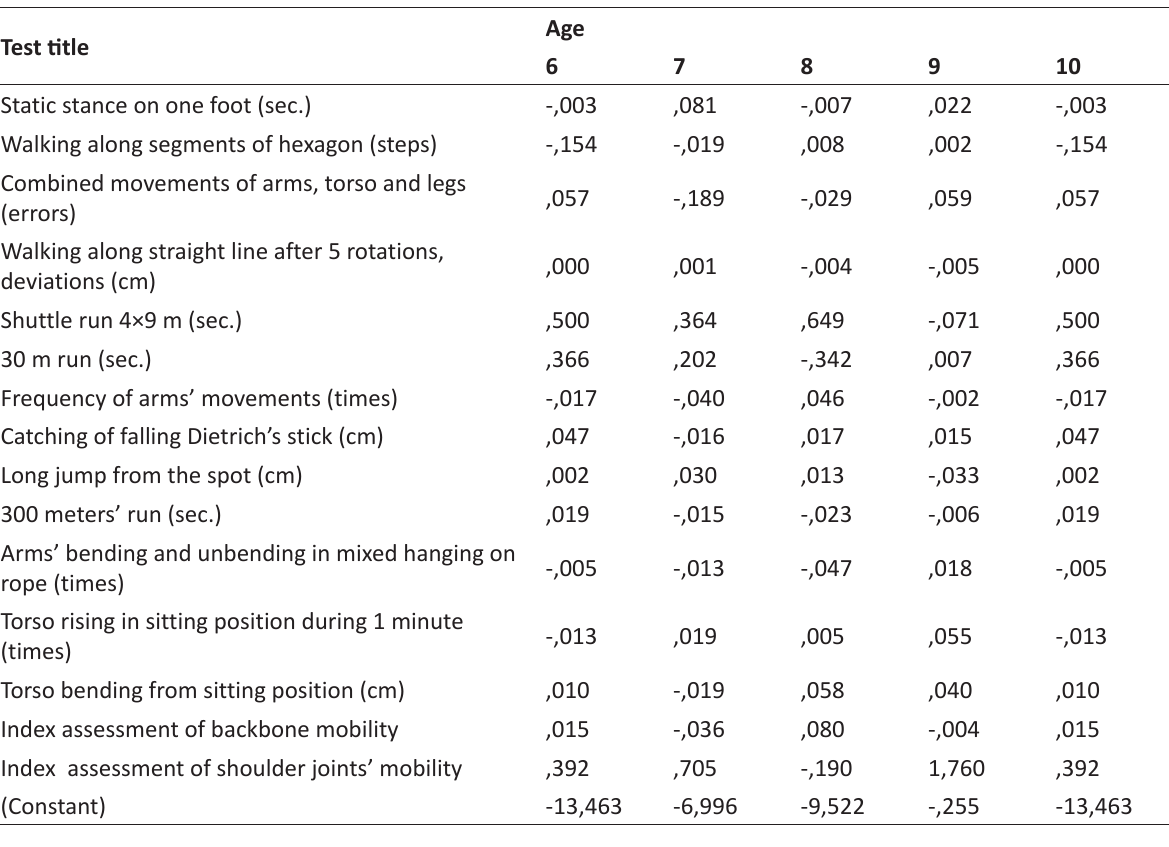
Table 2. Functions in groups’ centrodes. 6–10 years old